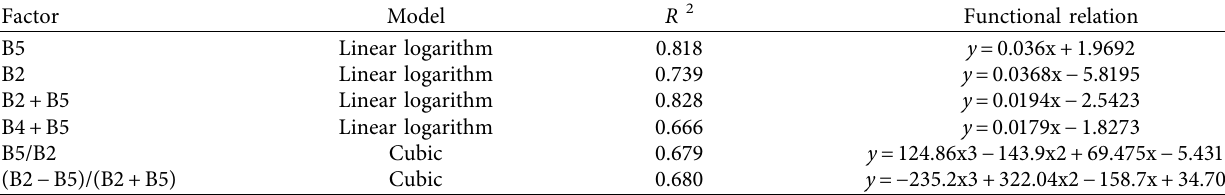
Table 6: Fitting model of COD concentration.